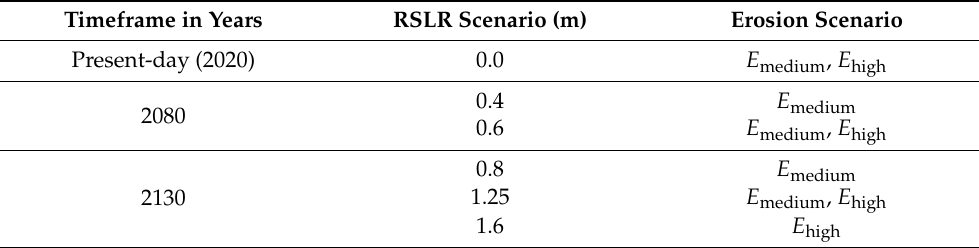
Table 1. Coastal erosion scenarios modelled. RSLR in metres relative to present-day